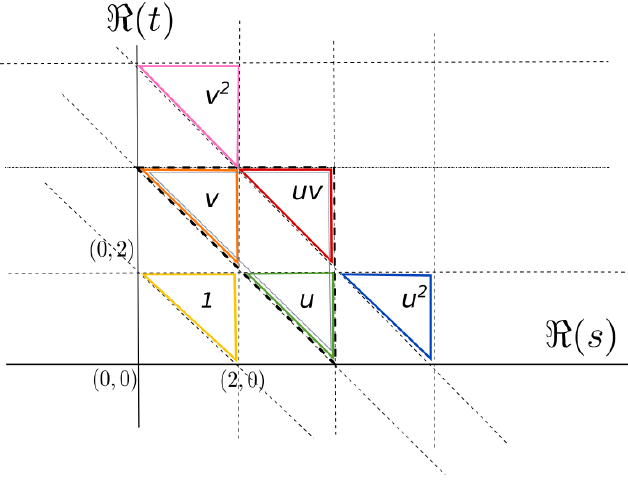
Figure 8 . The fundamental domains for the Mellin transform of R H